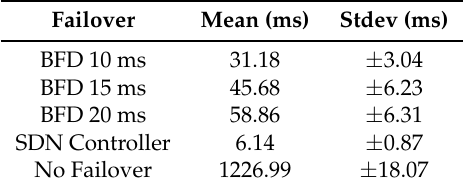
Table 3. Interruption time against different resilience